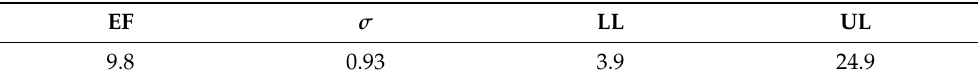
Table 5. Expected value, standard deviation, and back transformed mean and standard deviation for the log-normal distribution expressed in g/ton of crude oil processed for organic HAPs.